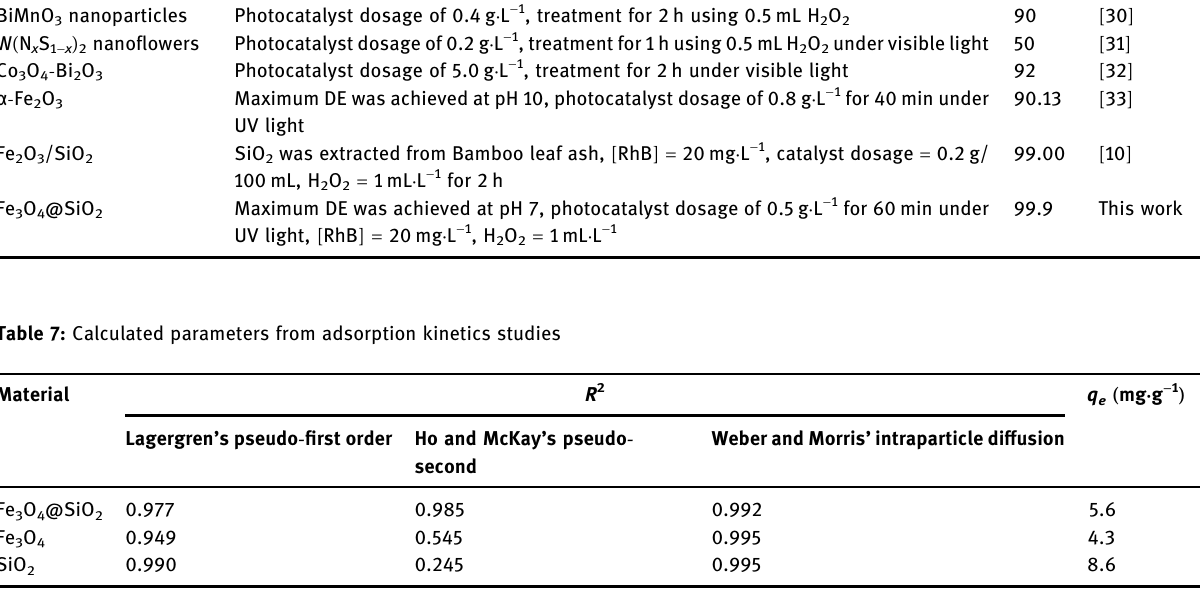
BiMnO 3 nanoparticles